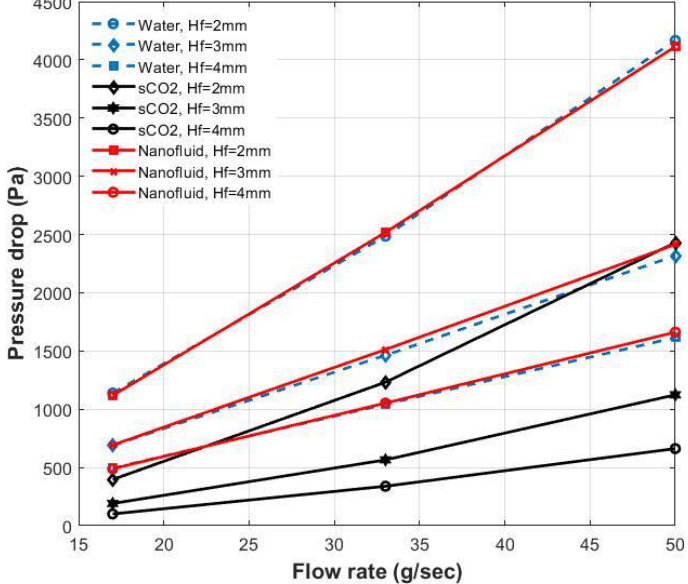
Figure 5. Pressure drops at different flow rates corresponding to different coolants and fin heights.